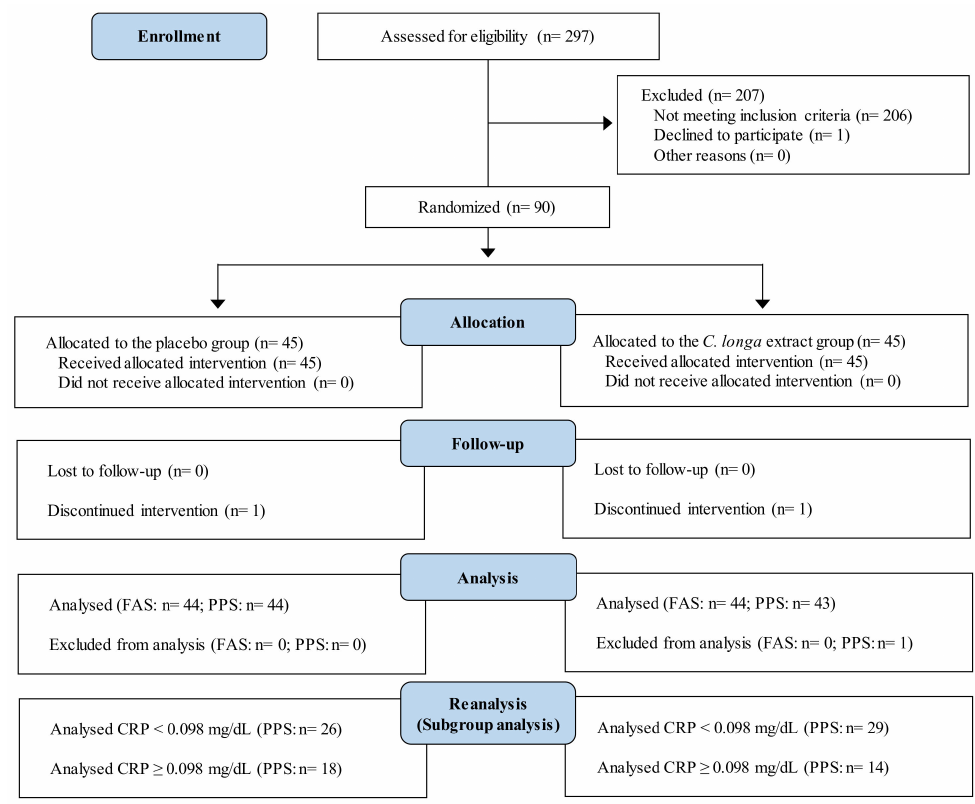
Figure 1. Study flow diagram (CONSORT 2010) in study 1.